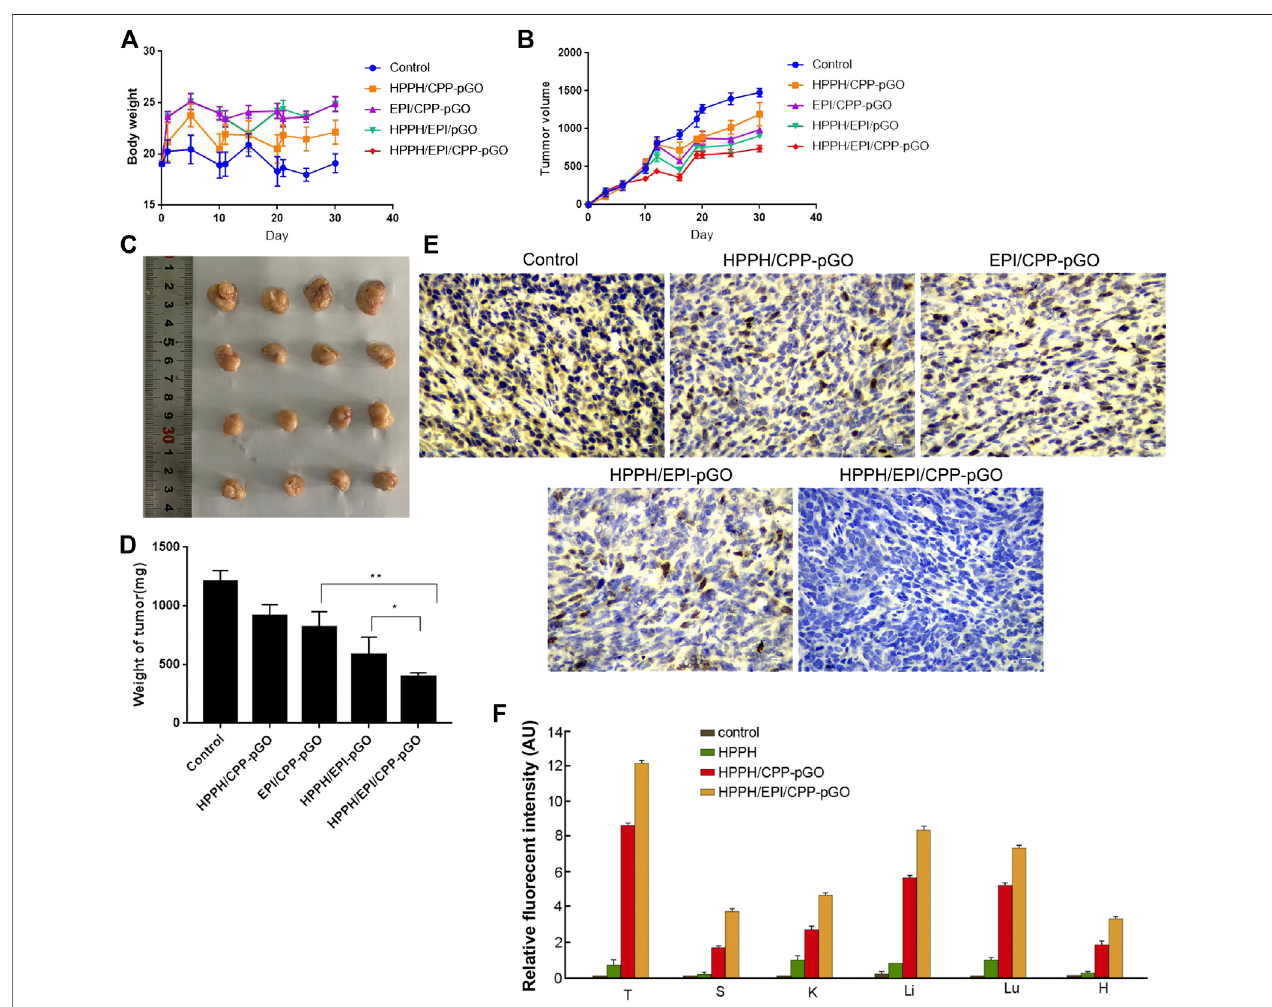
FIGURE4| HPPH/EPI/CPP-pGOexhibitedenhancedantitumoreffectinosteosarcomaxenograftmice. (A) Thebodyweightofosteosarcomaxenograftmicewithdifferent treatments, including saline solution (control group), HPPH/CPP-pGO (containing 1 mg/kg of HPPH), EPI/CPP-pGO (containing 5 mg/kg of EPI), HPPH/EPI/pGO (containing 1 mg/kg of HPPH and 5 mg/kg of EPI), or HPPH/EPI/CPP-pGO (containing 1 mg/kg of HPPH and 5 mg/kg of EPI). (B) The tumor volumes of micewith different treatments for 30 days. (C) The tumor image of mice with different treatments on day 30. (D) The tumor weights of mice with different treatments on day 30. (E) The Ki-67 expression of mice with different treatments by immunohistochemistry. (F) Quantitative analysis of the fl uorescence intensity of the tumors and organs of mice after 24 h of drug injection. T, tumor; S, spleen; K, kidney; Li, liver; Lu, lung; H, heart. N (cid:2) 4 in each group.